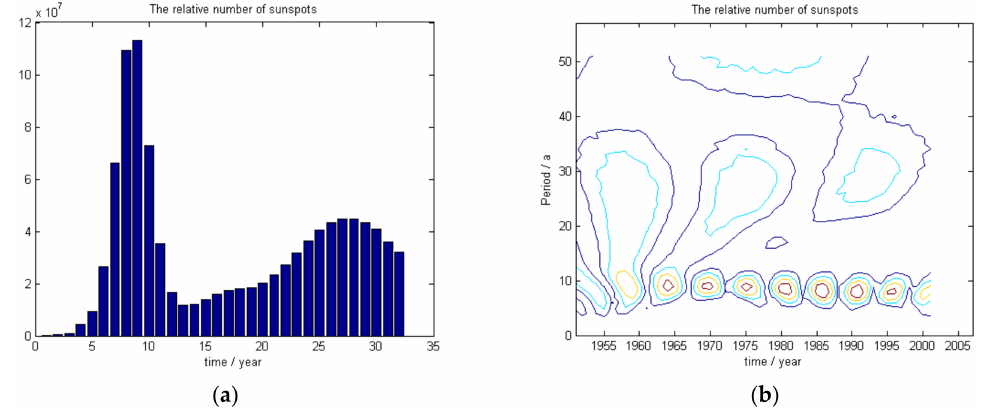
Figure 2. Wavelet analysis of sunspots. ( a ) Wavelet analysis variance; ( b ) Wavelet coefficient isoline.